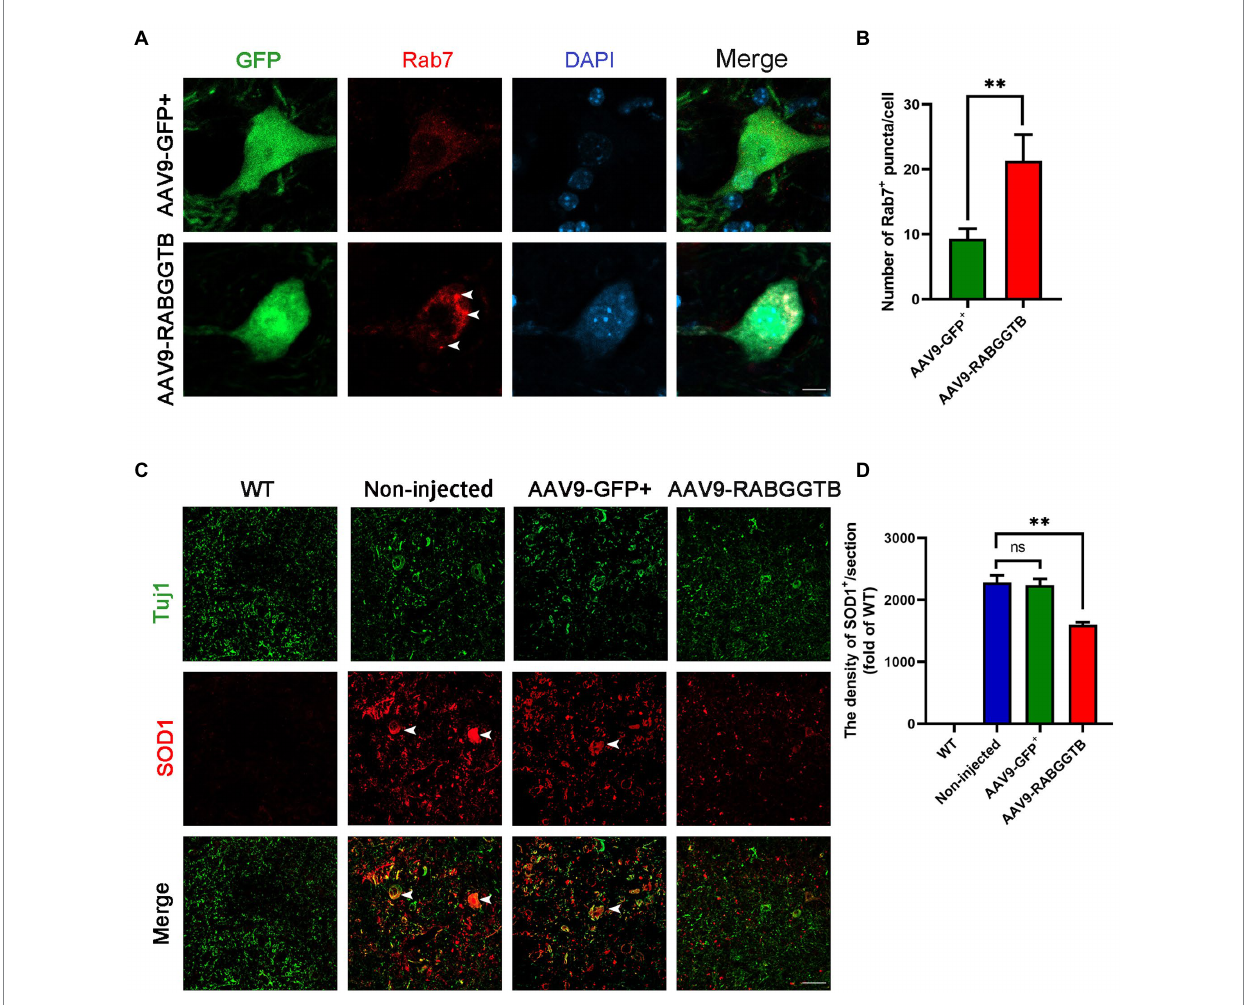
FIGURE 3 Overexpression of RabGGTB can increase the recruitment of Rab7 to membranes and reduced the abnormal aggregation of SOD1 protein. (A) Immunofluorescence labeling of Rab7 (red) in GFP-positive motor neurons (green) at 120 days (Scale bars, 10 μ M). (B) Quantitative analysis of Rab7- positive puncta. (C) Representative micrographs of lumbar spinal cord sections with WT, non-injected, and AAV9-GFP + -treated SOD1 G93A mice, and AAV9-RabGGTB-GFP + -treated SOD1 G93A mice. Immunofluorescence staining of SOD1 in the lumbar spinal cord at 120 days (scale bars, 50 μ M). (D) Quantification of relative fluorescence intensity of SOD1 in the lumbar medulla of WT mice, non-injected SOD1 G93A mice, SOD1 G93A mice injected with AAV9-GFP + , and SOD1 G93A mice injected with AAV9-RabGGTB-GFP + . Data represent the mean ± SEM, n = 5 mice per group; p -values were determined using one-way ANOVA. Error bars denote the SEM. * p <0.05, ** p <0.01, *** p <0.001. ns: no